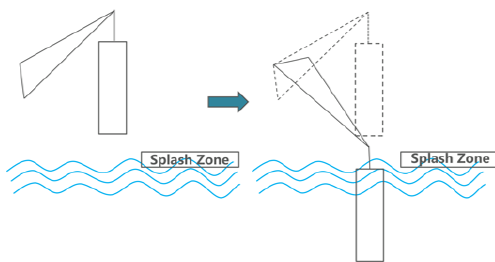
Figure 2: Target stage one: load descending from air to total immerse.